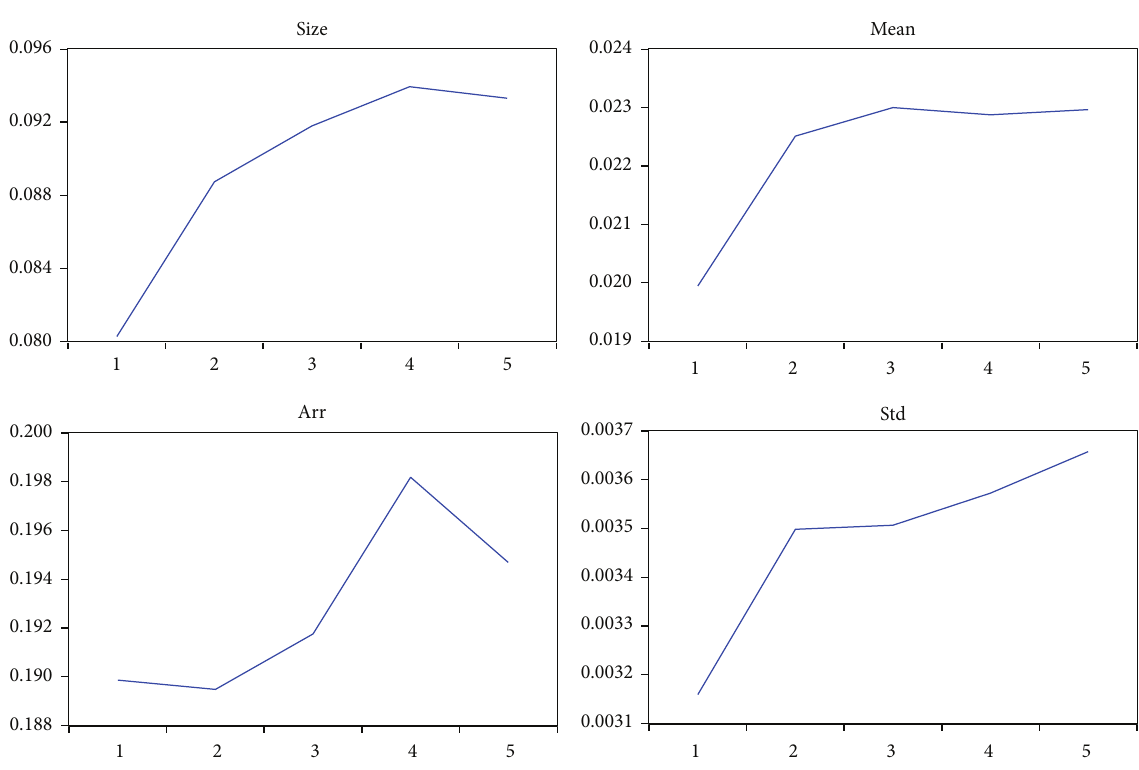
Figure 3: Trend of jump components for